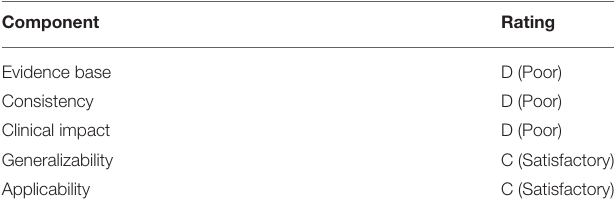
TABLE 3 | NHMRC matrix to summarize the evidence